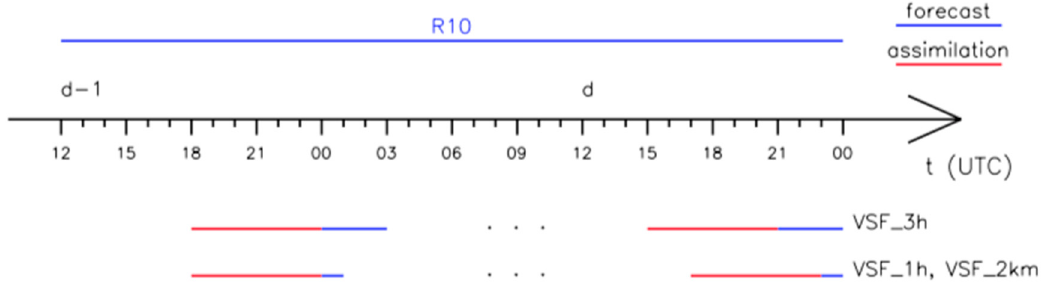
Figure 6. Scheme used for the Very Short-term Forecast (VSF) runs. For each line, the dots indicate that simulations between the first and the last (6 for VSF_3h; 22 for VSF_1h and VSF_2km) follow the same scheme of the two shown examples. The red color represents the assimilation phase while the blue one represents the forecast phase.